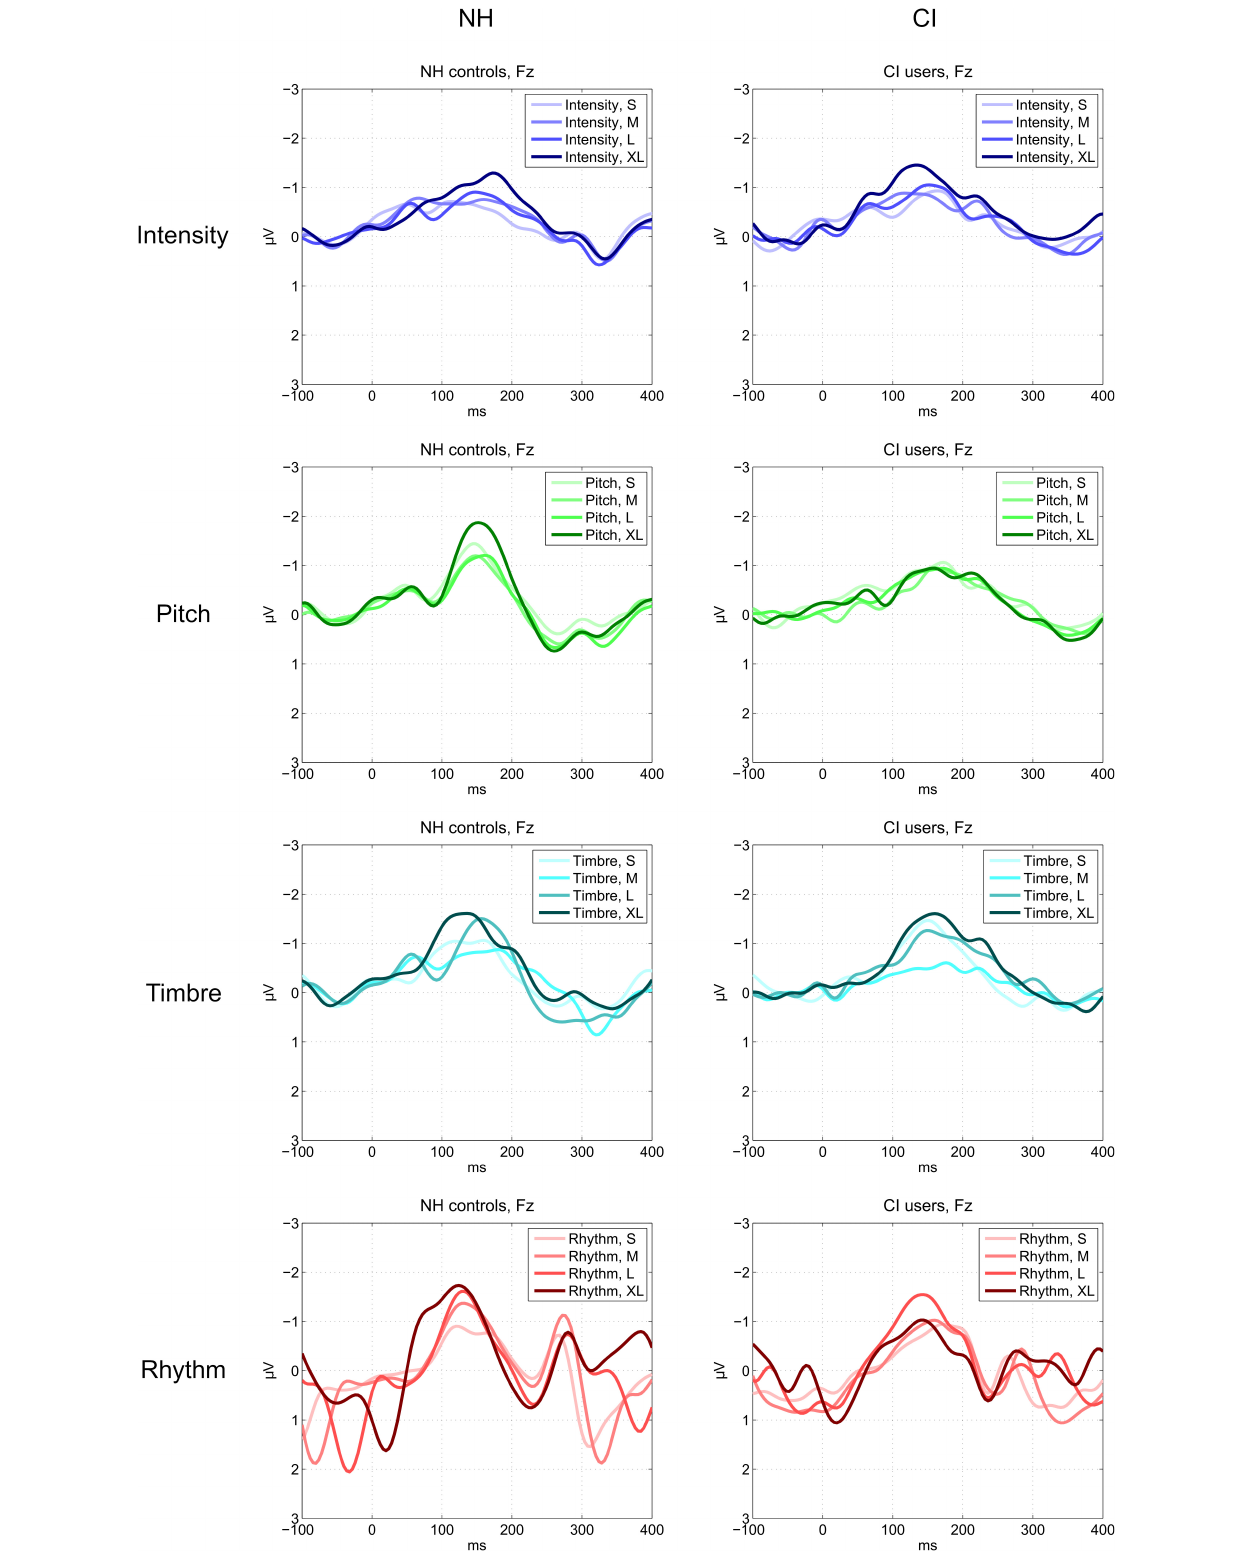
FIGURE 4 | MMN responses to deviants for each feature, level, and group measured at the Fz electrode.